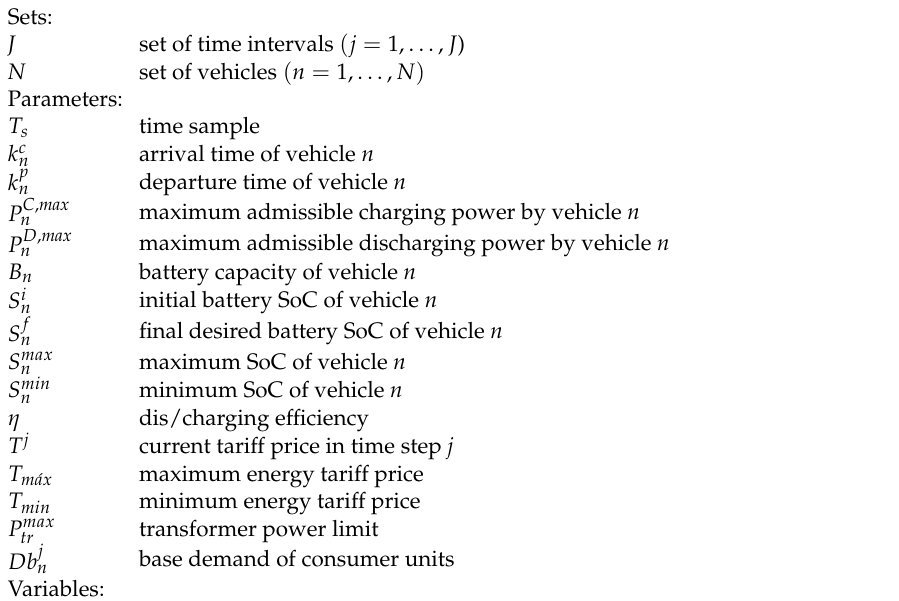
Table 3. Notation for the optimization